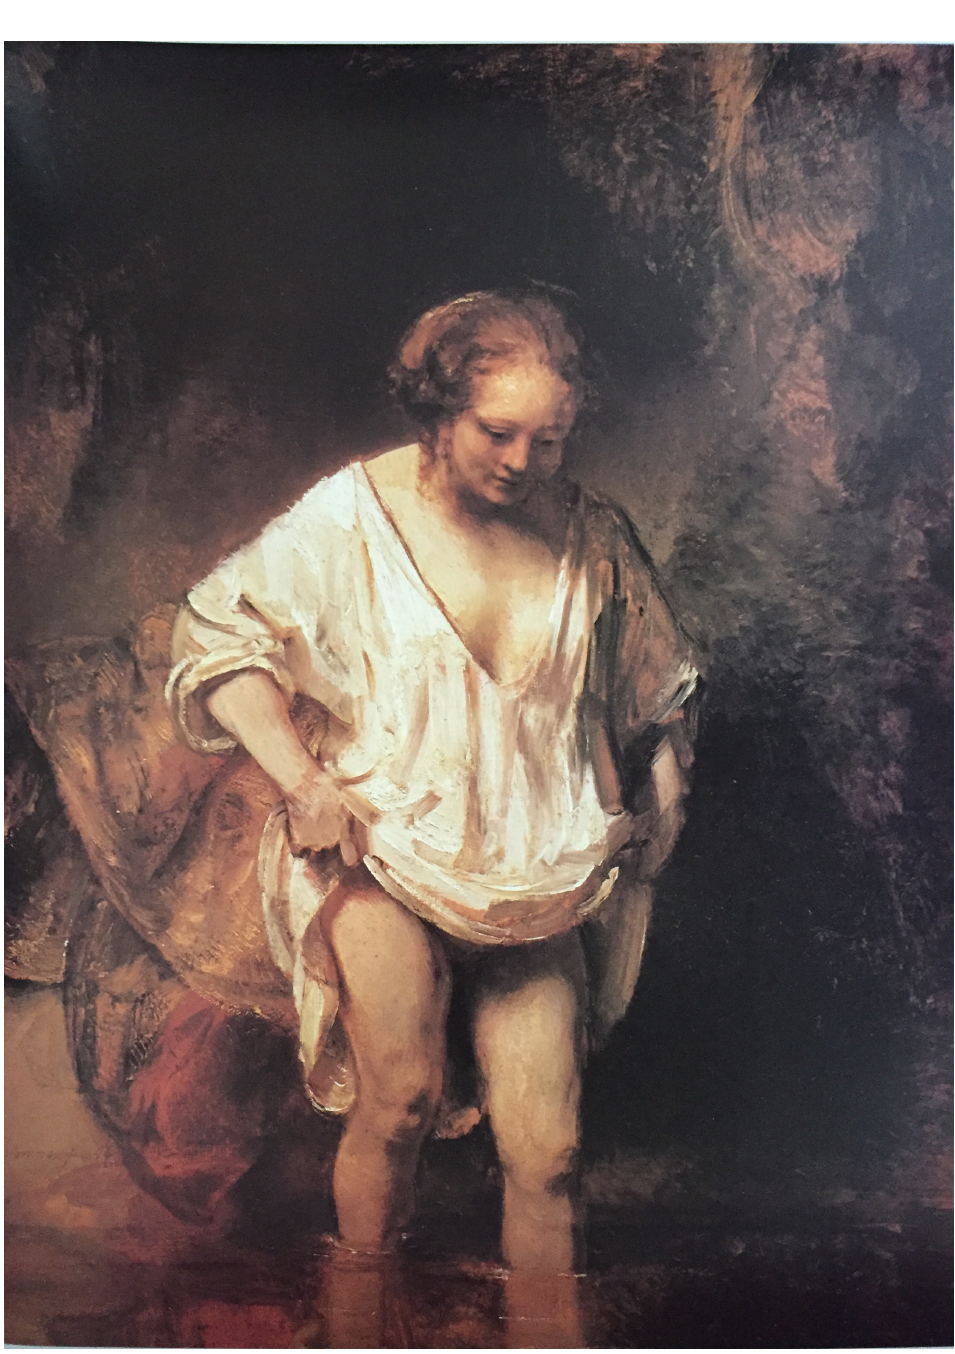
Figure 1: Rembrandt, Woman Bathing in a River , 1654